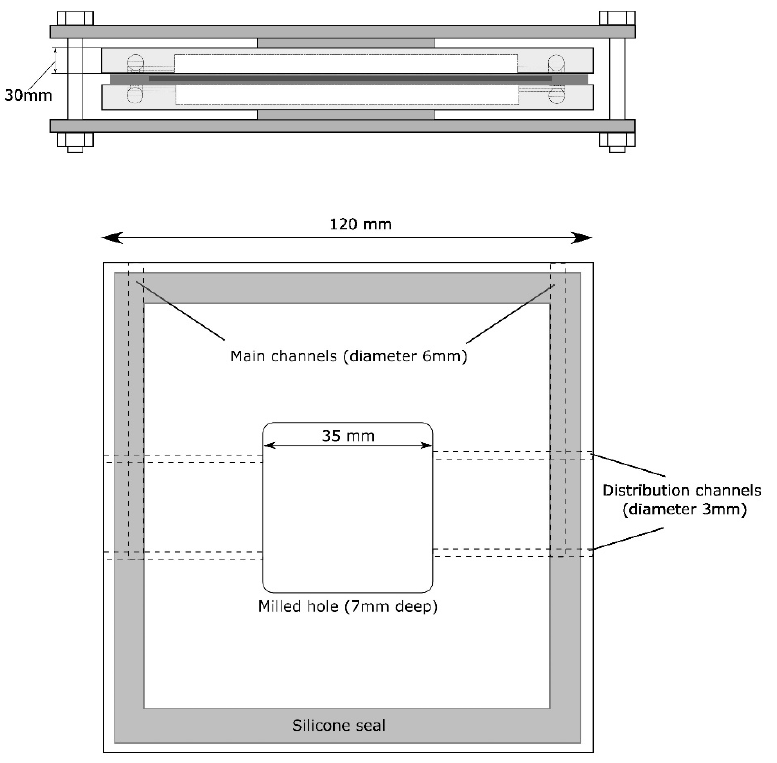
Figure 3. The Tarflen PTFE V1 module.